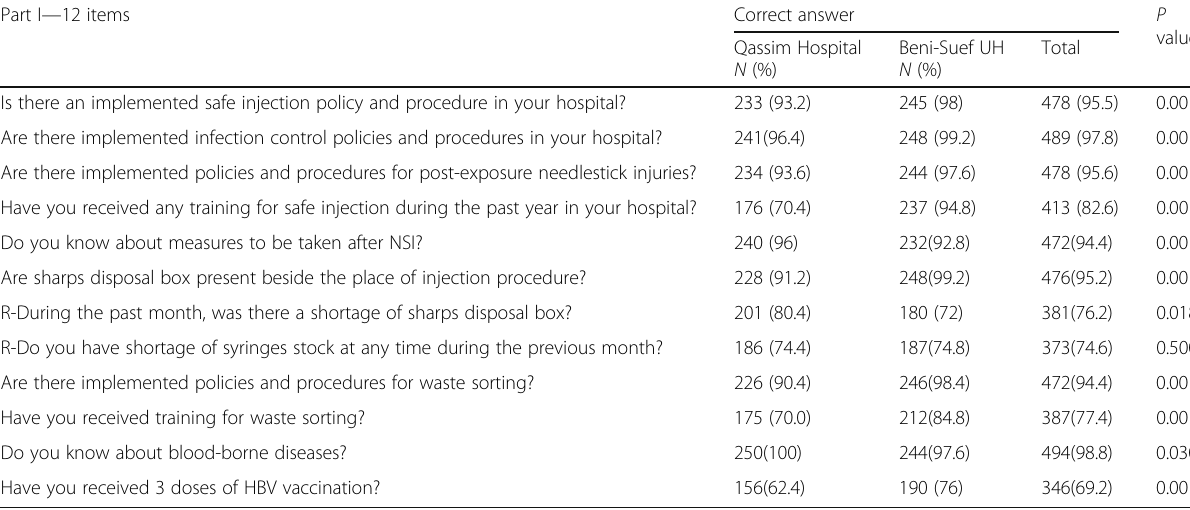
Table 2 Awareness of safety injection among the nurses in Beni-Suef, Egypt, and Qassim, KSA, 2017 Part I — 12 items